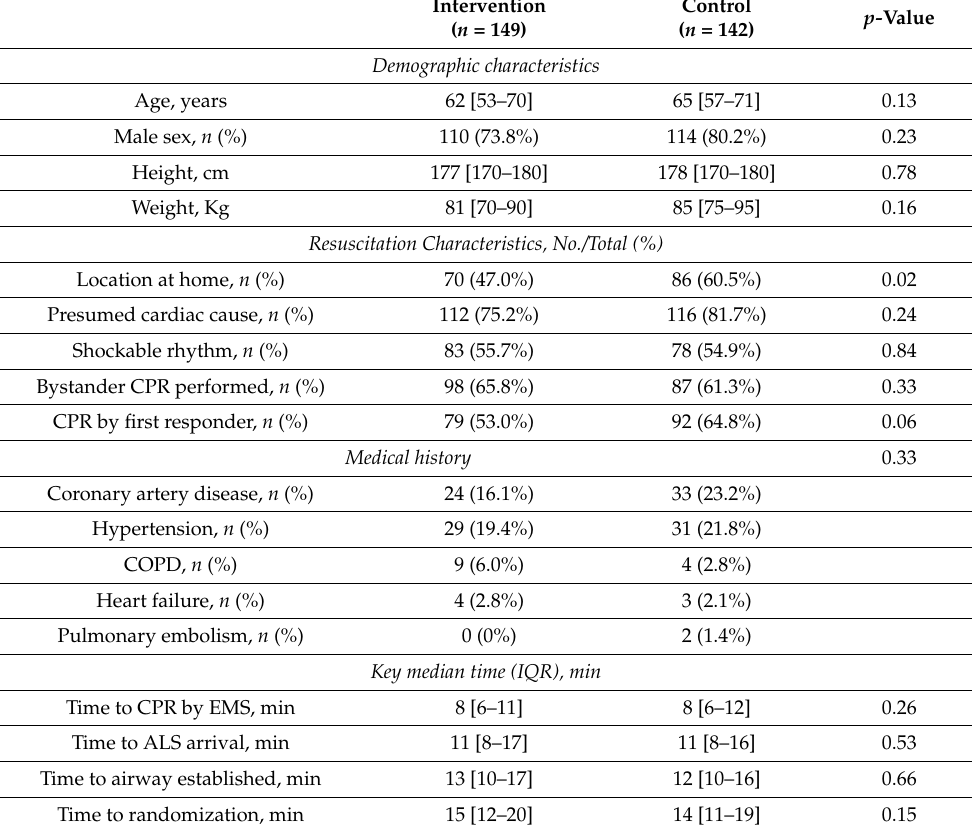
Table 1. Baseline characteristics of patients, according to the trial arm assignment. Data are reported as median [IQRs] or count (%). CPR = cardiopulmonary resuscitation; EMS = emergency medicine system; ALS = advanced life support; COPD = chronic obstructive pulmonary